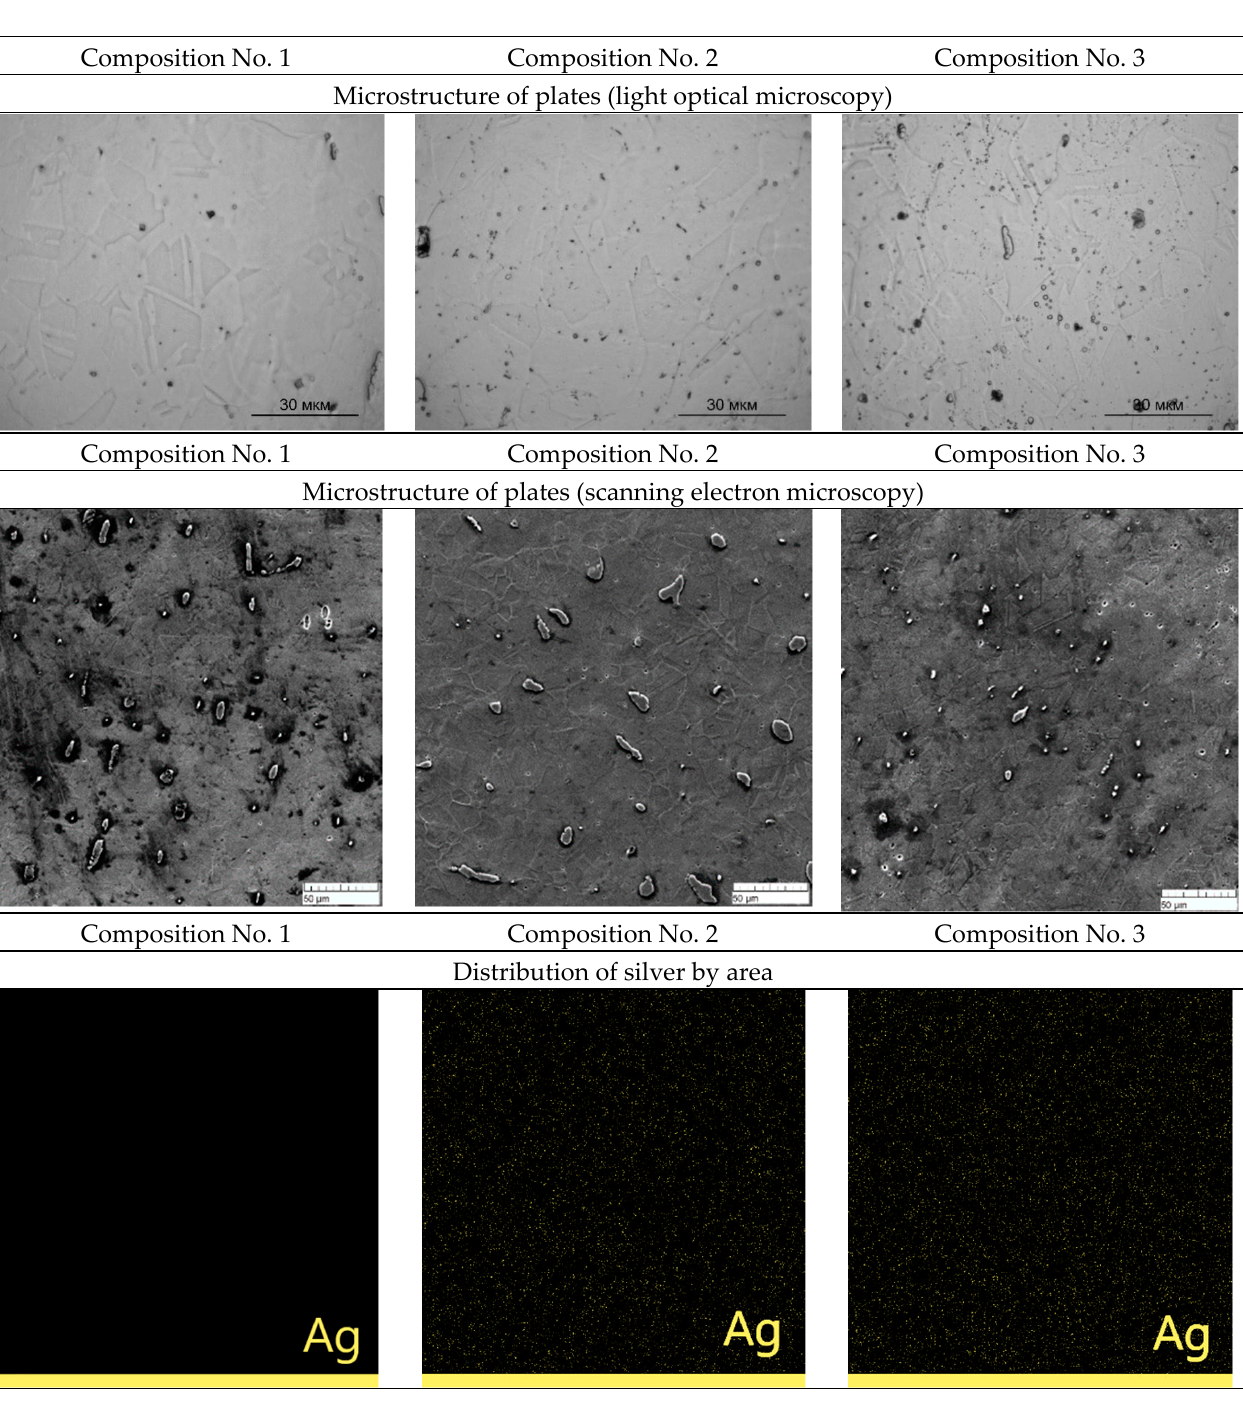
Figure 3. Influence of silver content on the microstructure of steel plates.